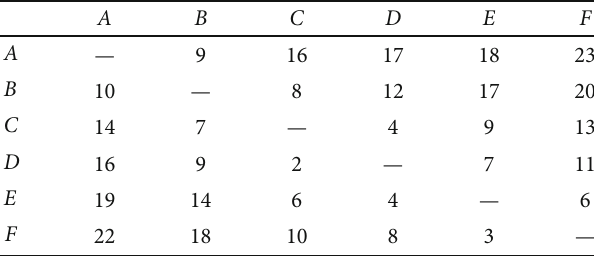
Table 5: Bus travel time in stations (units: